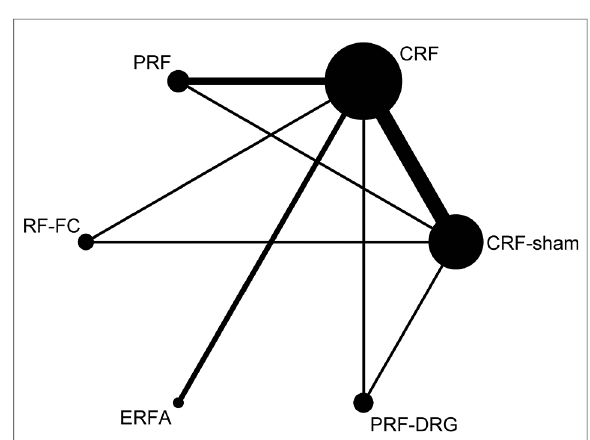
FIGURE 2 Network of eligible comparisons for the management of CLBP. The line indicates direct comparison of interventions, and the thickness of the line corresponds to the number of patients in the comparison. The size of the node corresponds to the number of studies that involve the